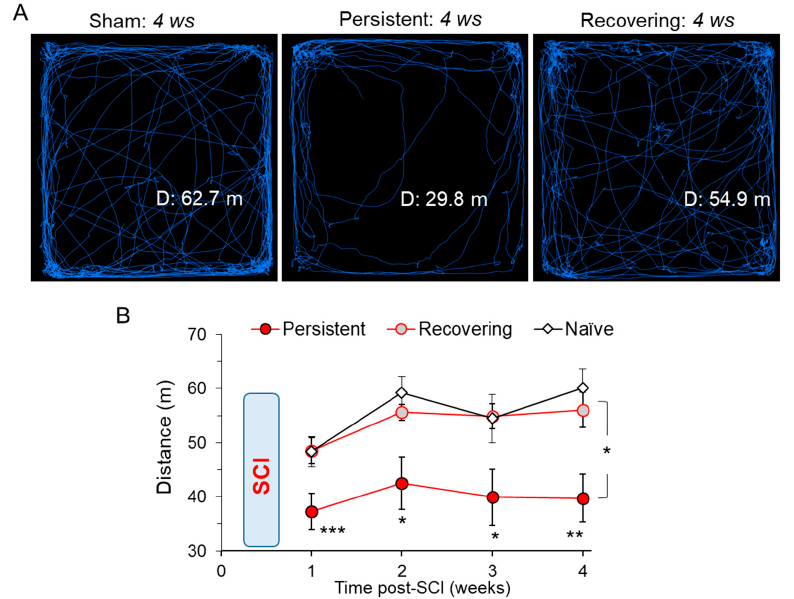
Figure 4. Changes in the locomotive activity between ‘persistent’ and ‘recovering’ groups of inured rats. ( A ) Snapshots show example recordings of the total distance travelled in the open-field arena (10-min duration) by a sham-operated rat and injure rats of the ‘persistent’ and ‘recovering’ groups taken at 4 weeks after injury. ( B ) Statistical summary of the time-dependent changes in locomotive activity in experimental groups. Data are mean ± SEM. * p < 0.05, ** p < 0.01, *** p < 0.001 (ANOVA with Tukey post-hoc test). No difference was found in locomotive activity between the naïve and sham-oper- ated groups (Figure S2 in Supplementary Materials). The regression analysis demon- strated that locomotive activity was correlated with the motor deficit, either the BBB scores ( ρ was 0.61 and 0.45, p < 0.05 at weeks 1 and 4, respectively; Figure S3A in Supple- mentary Materials) or the Ashworth rating scores ( ρ was − 0.61 and − 0.53, p < 0.05, respec- tively; Figure S3B in Supplementary Materials). 3.5. Thermal Pain Hypersensitivity after a Mild SCI We next examined whether and how nociceptive sensitivity is changed in the injured animals in the ‘persistent’ and ‘recovering’ groups. First, we carried out testing of the ther- mal nociceptive threshold. In full agreement with our previous findings [17], all injured rats developed thermal hypersensitivity on the contralateral hind paw. The hypersensi- tivity has developed at week 1 ( p < 0.05, ANOVA) to a similar extent between the two groups of injured animals. The average thresholds were 13.4 ± 0.5 s in the control (n = 11), but 10.3 ± 0.6 s (n = 8) in the ‘persistent’ and 8.9 ± 0.7 s (n = 15) in the ‘recovering’ groups ( p < 0.01 compared with the naïve or sham-operated groups, ANOVA; Figure 5A). The hypersensitivity of thermal modality persisted over weeks 2 to 4 ( p < 0.001 compared with the corresponding time-point in naïve or sham-operated animals, ANOVA). There was a significant trend between the thermal hypersensitivity and motor deficit (BBB: ρ = 0.79, p < 0.001, Figure S4B in Supplementary Materials; Ashworth: ρ = − 0.69, p < 0.001; data not shown). The thermal hypersensitivity was confirmed on the ipsilateral hind paw for the ‘re- covering’ SCI animals. A decreased thermal threshold was detected as soon as week 1